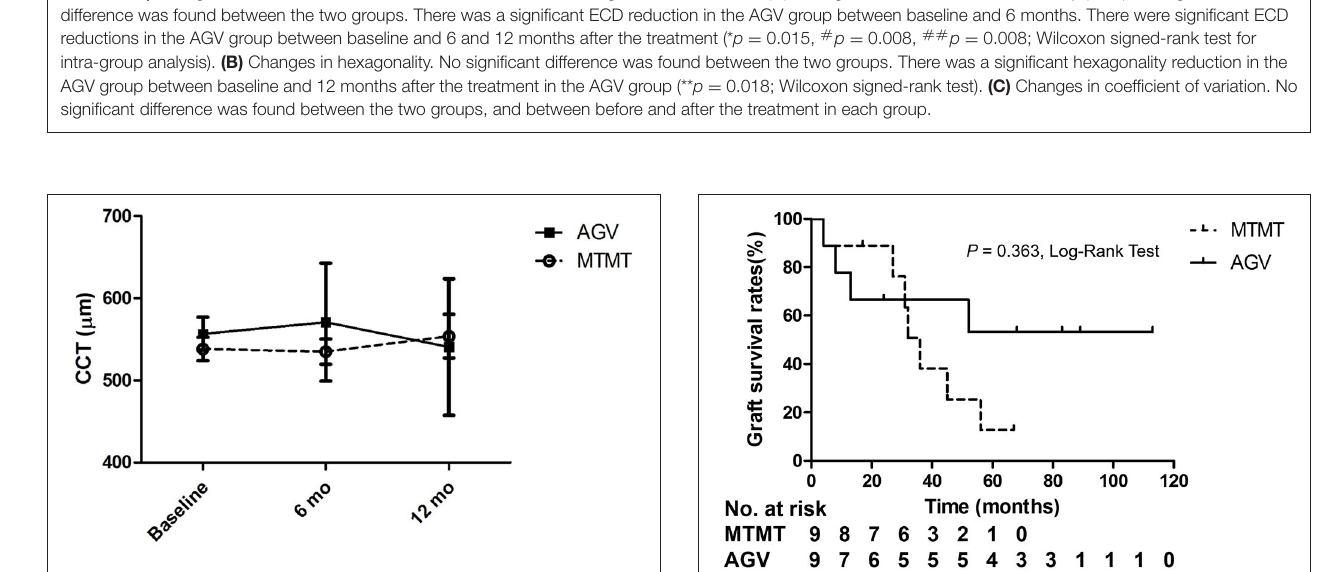
FIGURE 4 | Changes in central corneal thickness (CCT) after anti-glaucoma treatment. No significant difference was found between the two groups, and between before and after the treatment in each group.